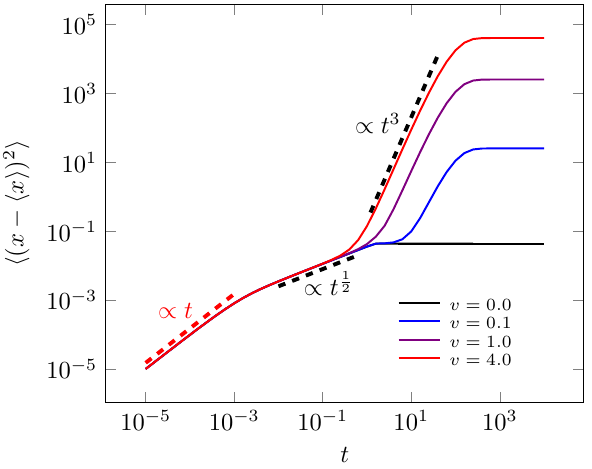
Figure 7. This figure represents time evolution of MSD behavior x axis (Equation (31)) to non-static stochastic resetting case. In this figure, we consider the parameter valuers as follow τ = 0.001, κ = 0.02 and different velocities to resetting